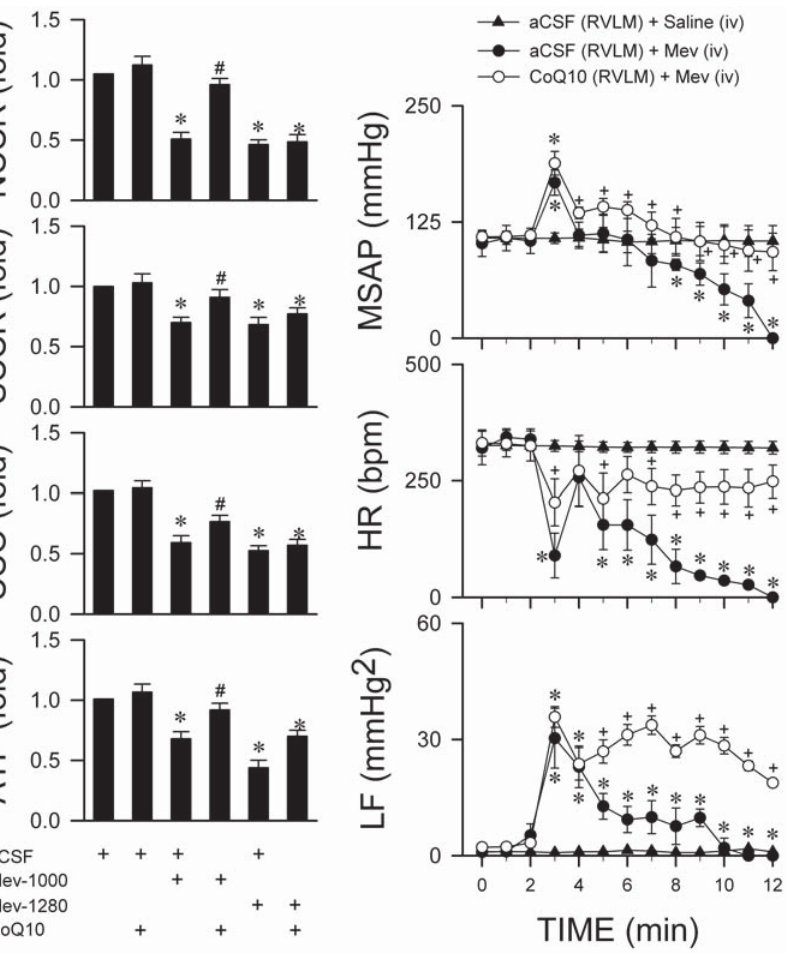
Figure 6. Bioenergetic failure in RVLM also accounts for the failure to resume spontaneous circulation after cardiac arrest. (Left column) Fold changes against aCSF-control group in enzyme activity of NCCR, SCCR or CCO and ATP production in mitochondria isolated from ventrolateral medulla of rats that were pretreated with microinjection bilaterally of coenzyme Q10 (CoQ10; 6 m g) or aCSF into the RVLM, followed by intravenous administration of Mev at 1000 or 1280 m g/kg. Values are mean 6 SEM of quadruplicate analyses from samples pooled from 5–7 animals per experimental group. * p , 0.05 versus aCSF group and # p , 0.05 versus corresponding aCSF + Mev group in the post hoc Scheffe´ multiple-range analysis following one-way ANOVA. (Right column) Also shown are effects of the CoQ10 or aCSF pretreatment on temporal changes in MSAP, HR or power density of LF component of SAP spectrum induced by intravenous (iv) administration of Mev (1000 m g/kg; at time zero) or saline. * p , 0.05 versus aCSF + saline group and + p , 0.05 versus aCSF + Mev group at corresponding time-points in the post hoc Scheffe´ multiple-range analysis following two-way ANOVA.